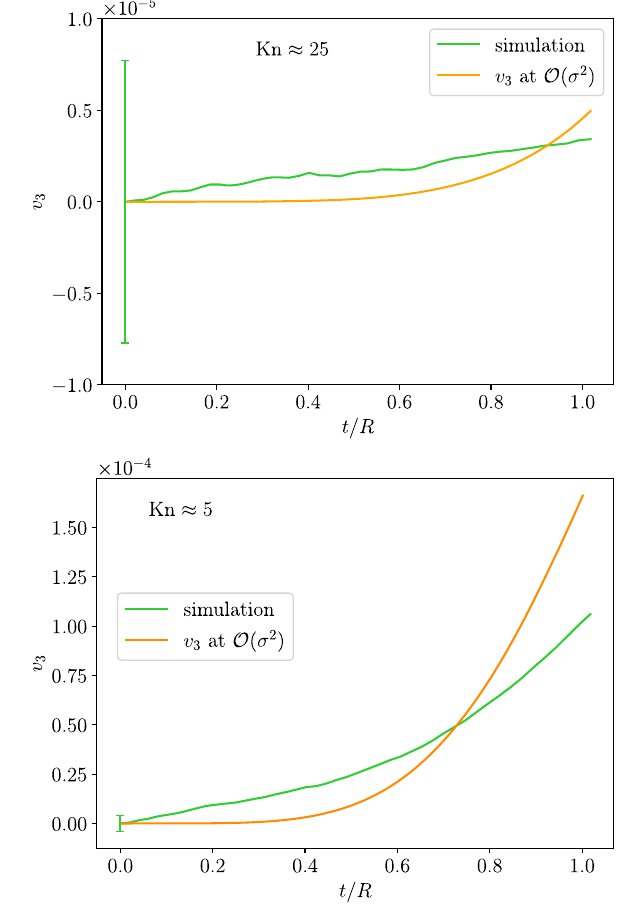
Fig. 5 Elliptic flow v 2 as a function of t / R for Kn ≈ 25 (top) and Kn ≈ 5 (bottom). Results from the numerical 2 → 0 simulations are shown in green and the analytical results are shown to O (σ) (blue) and O (σ 3 ) (orange). Both analytical curves include terms up to O ( t 15 )